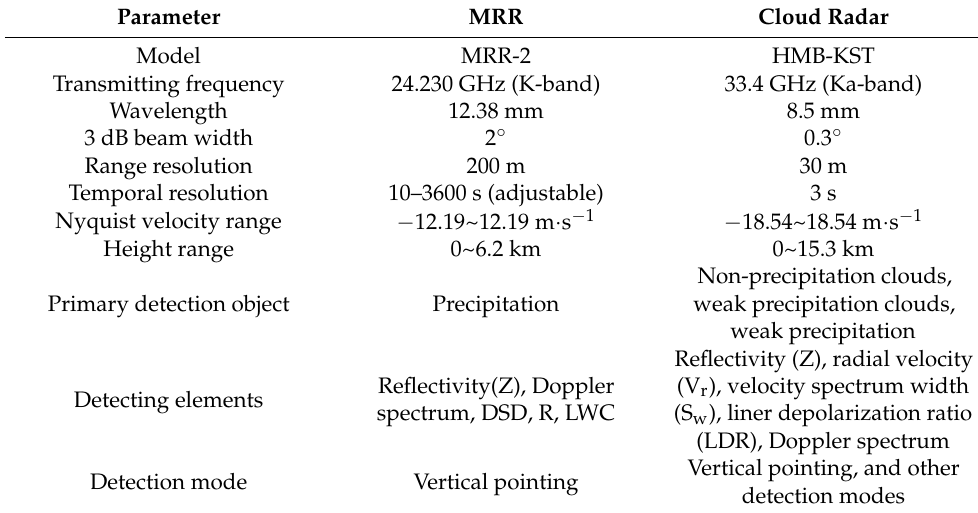
Table 1. The main specifications of MRR and Cloud Radar.